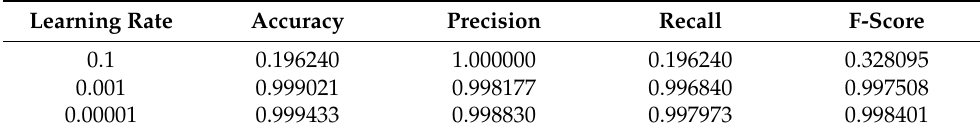
Figure 6. Training and validation accuracy of the deep ANN.